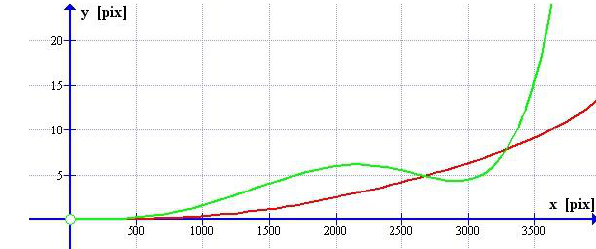
Figure 5. Comparison of distortion values for both methods of calculation. Red – self-calibration with Agisoft (parameters k1, k2, k3 of radial distortion); Green – single image calibration (parameters k1, k2, k3 of radial distortion).